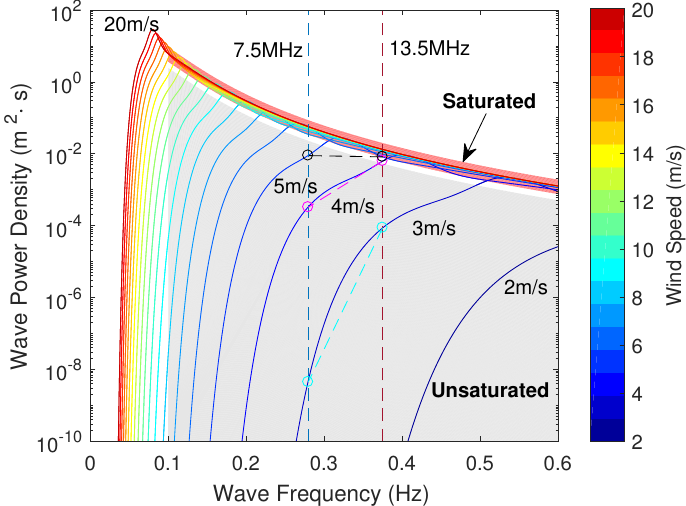
Figure 1. Ocean wave non-directional spectra under different wind speeds (JONSWAP spectrum [18] is selected for example). The wave frequencies resonant to two radar frequencies (7.5 MHz and 13.5 MHz) are indicated by the location of the vertical dashed